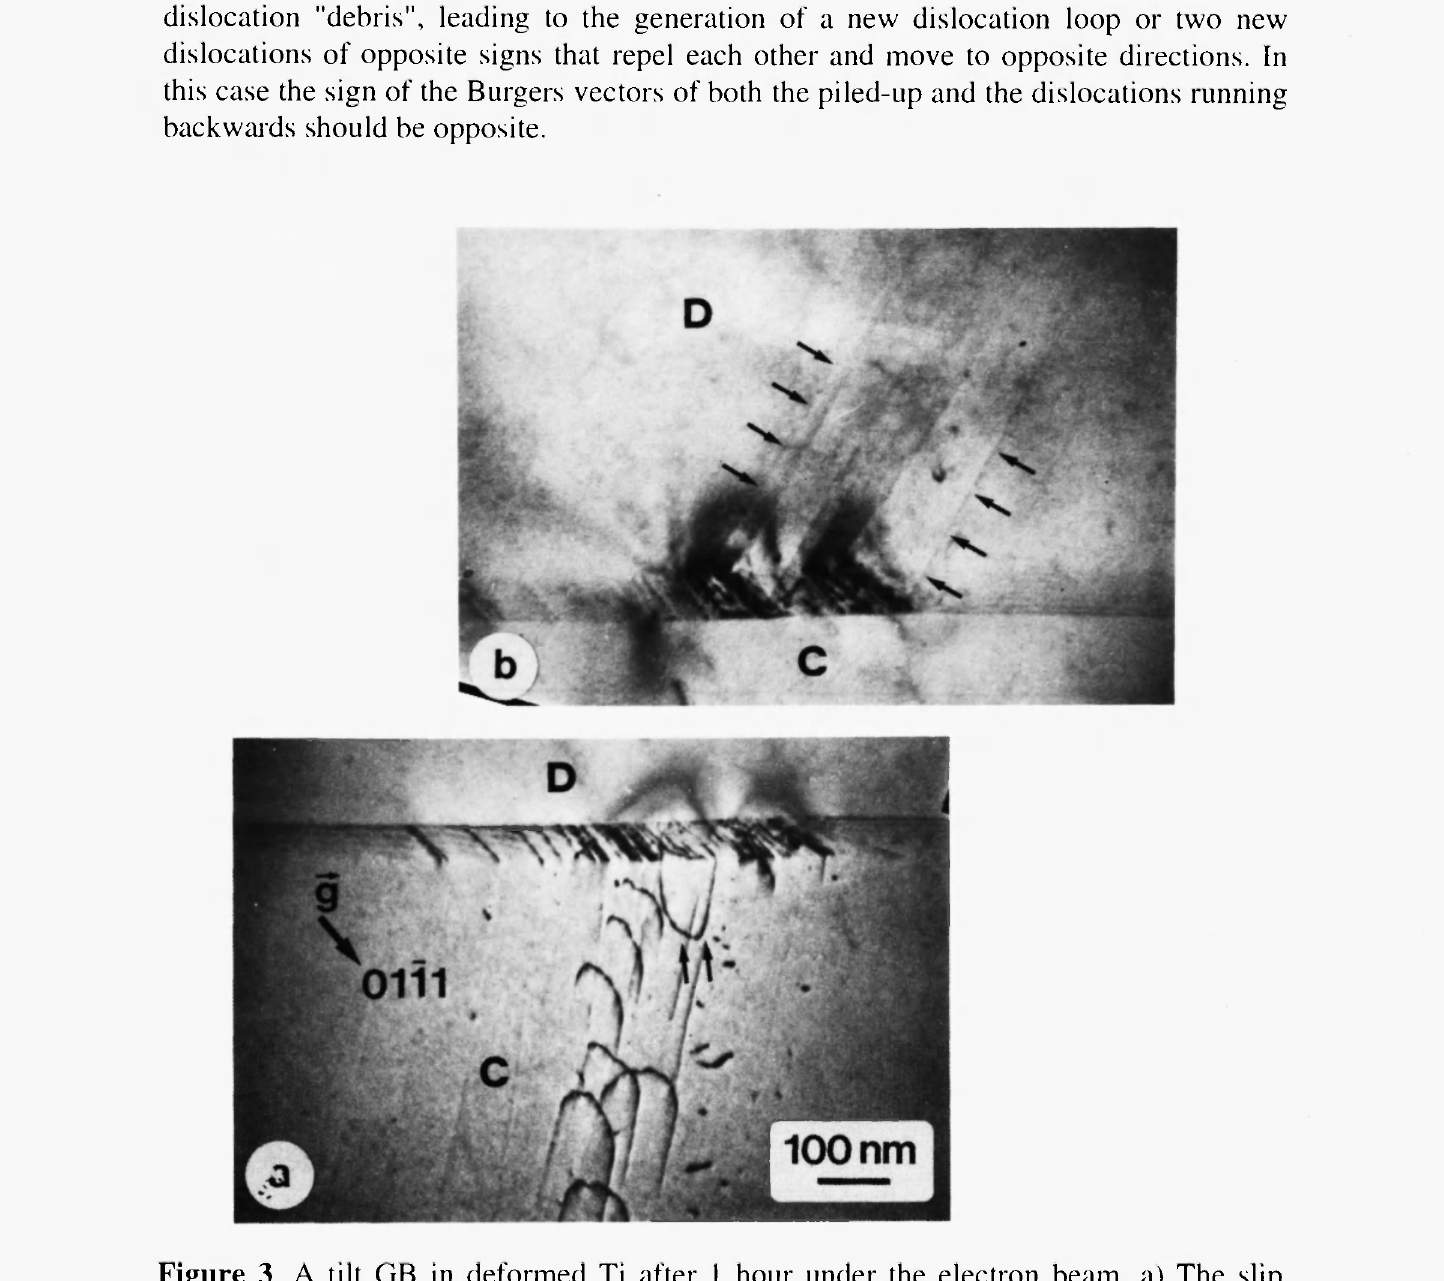
Figure 3. A tilt GB in deformed Ti after 1 hour under the electron beam, a) The slip transmission mechanism has been re-activated; the incidence of a matrix dislocation in the GB results in the reflection of the dislocation gliding on the already activated (1Ϊ0Ϊ) slip plane of grain C; the reflected dislocation is depicted by small arrows, b) The traces of the slip lines in grain D, resulting from the ejection of trapped GB dislocations, are depicted by small